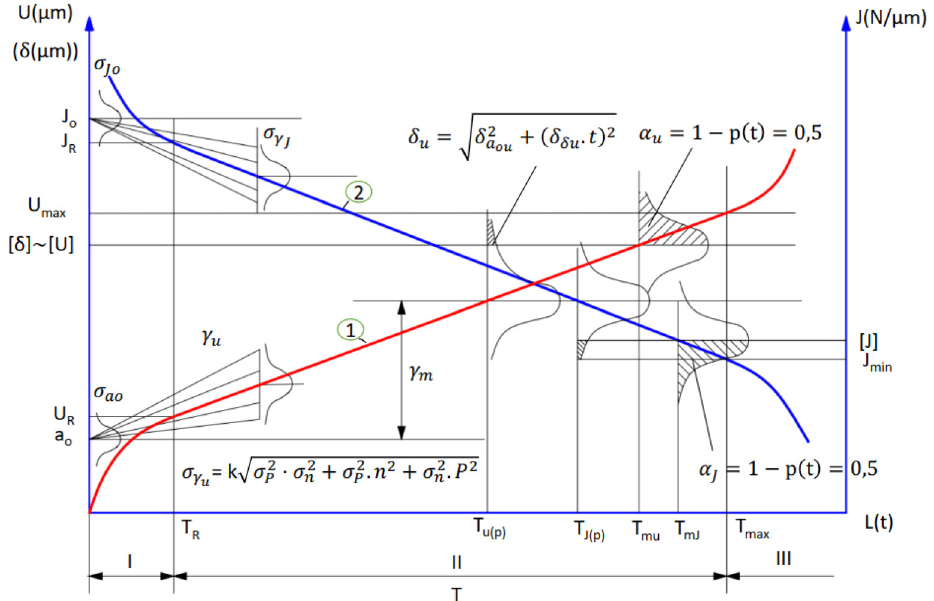
Fig 1. Diagram for calculating service life and reliability according to wear and